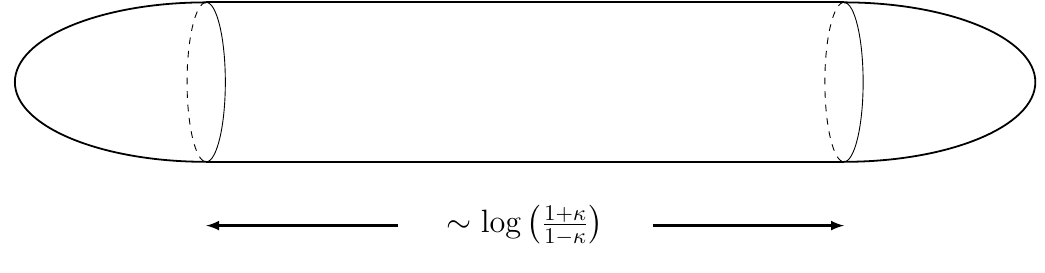
Figure 2 . A depiction of the target manifold of the NLSM (1.6) for 1 (cid:0) (cid:20) (cid:28) 1. Is the non-ultralocal structure (1.5) an immanent property of an integrable NLSM,